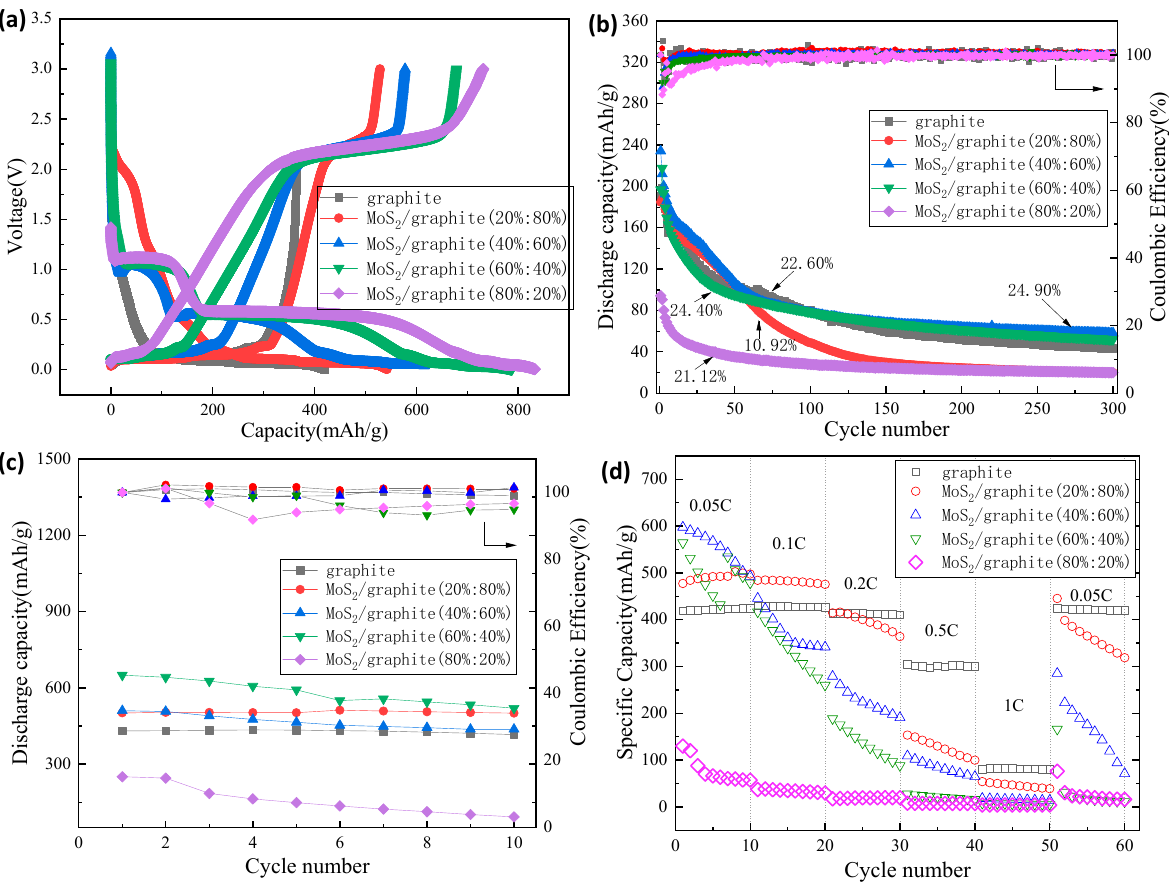
Figure 4. ( a ) Initial charge–discharge capacity curve; ( b ) 1 C cycling; ( c ) 0.05 C cycling; ( d ) Rate capability curve.